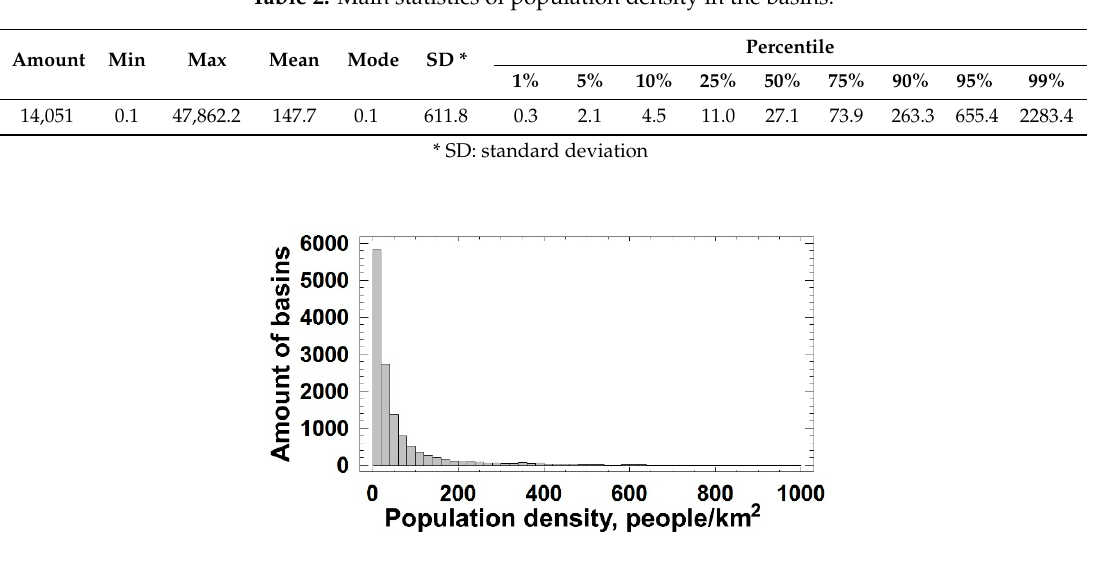
Table 2. Main statistics of population density in the basins.